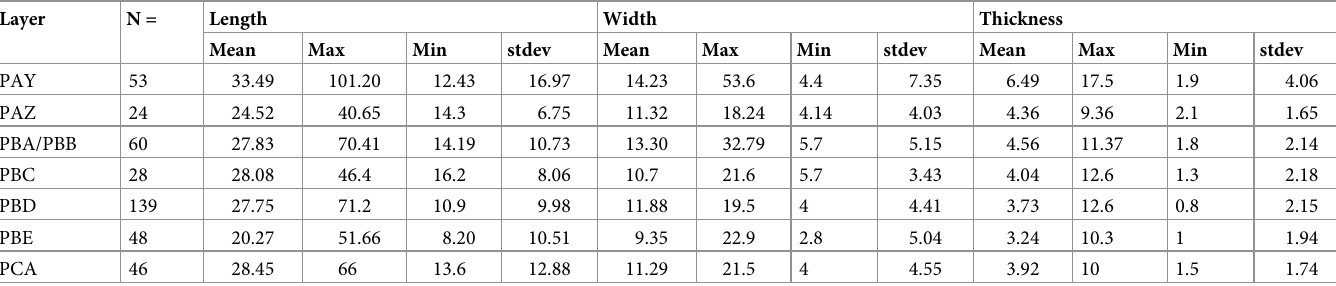
Table 4. Dimensions of the complete blades at KDS expressed in mm.